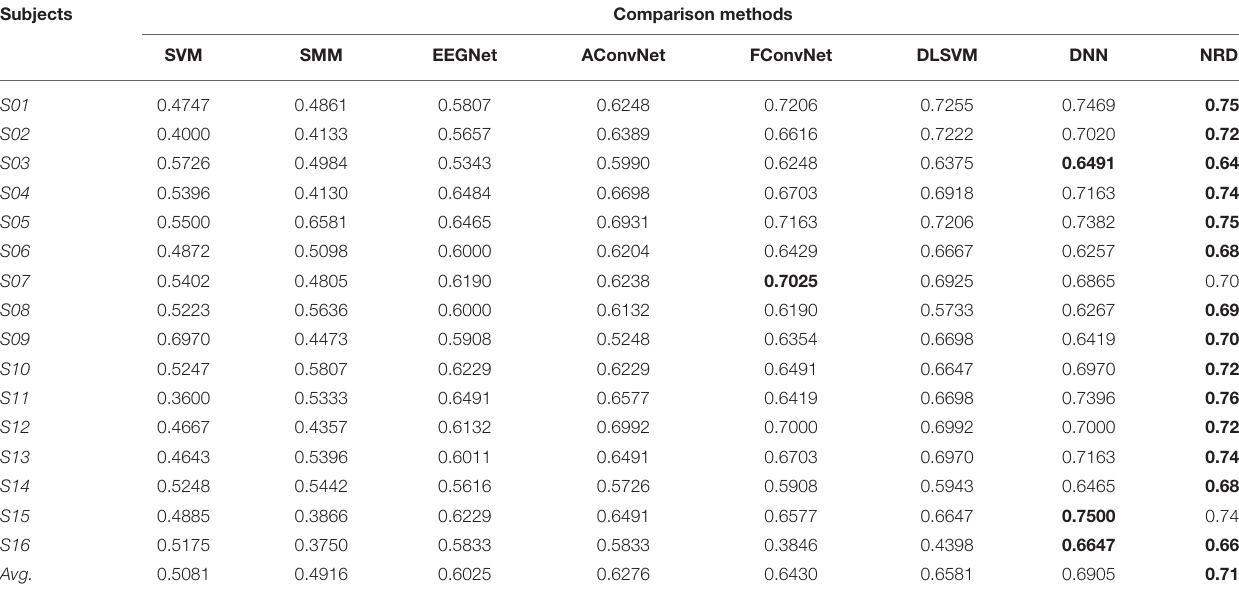
The best classification results are